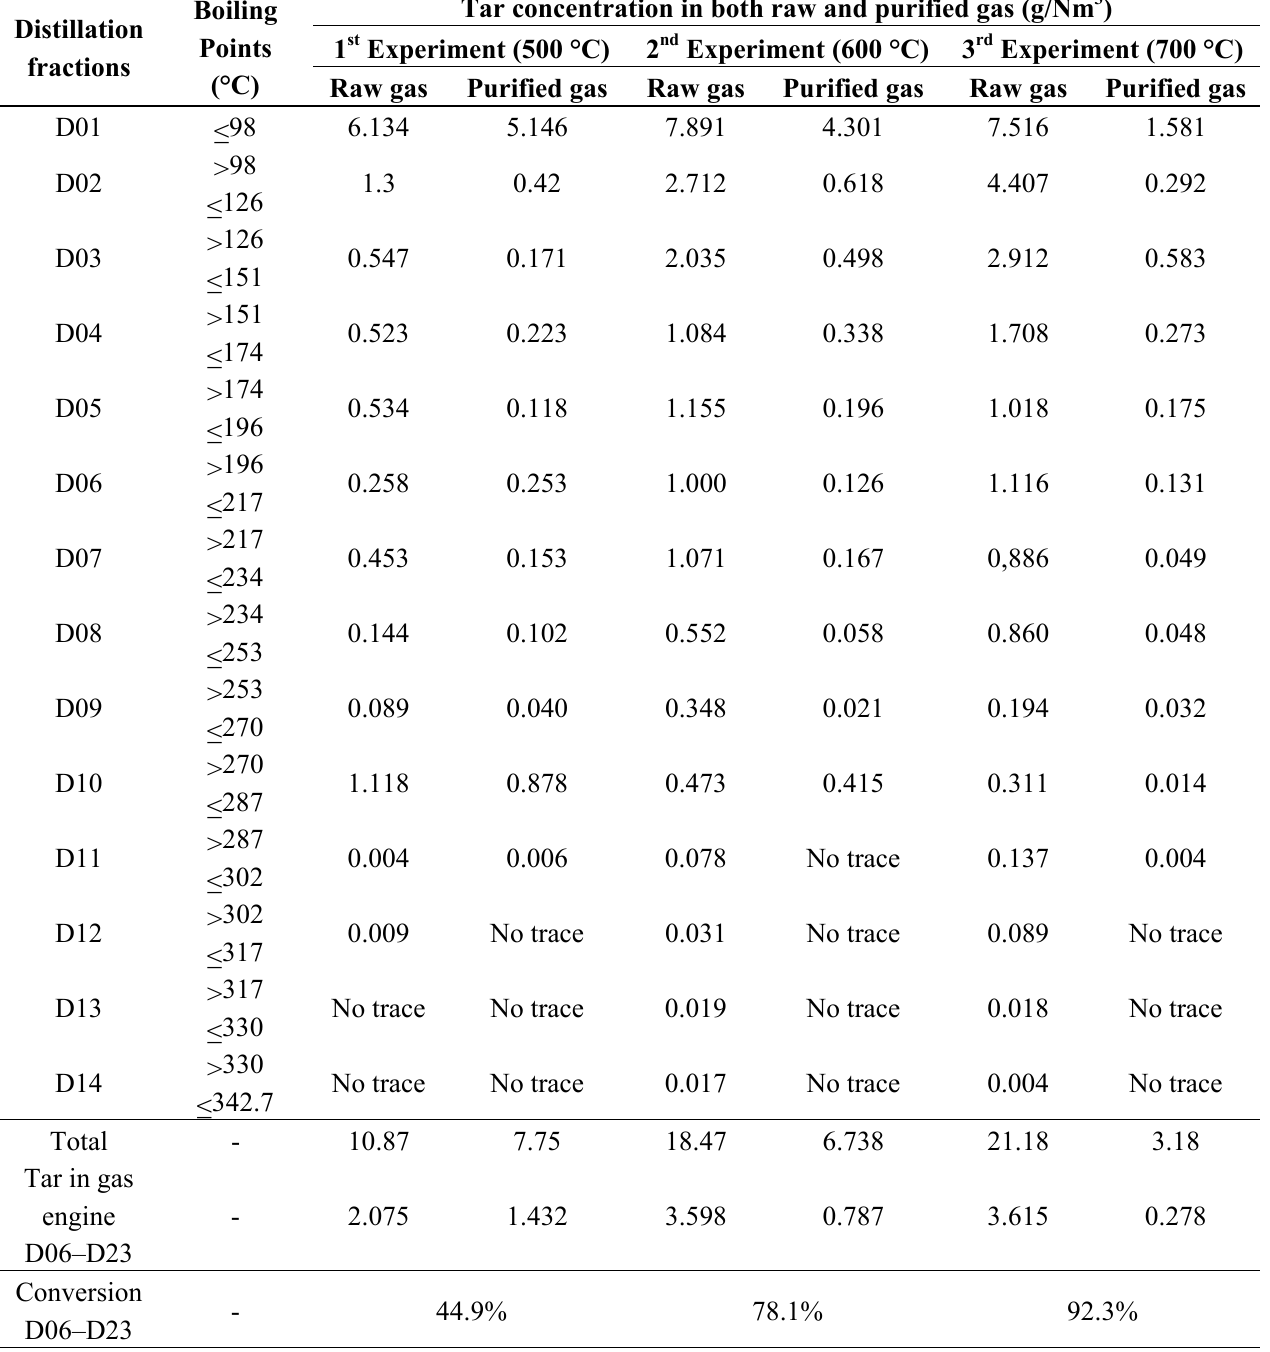
Table 2. Conversion of tarry compounds under flow rate of 20